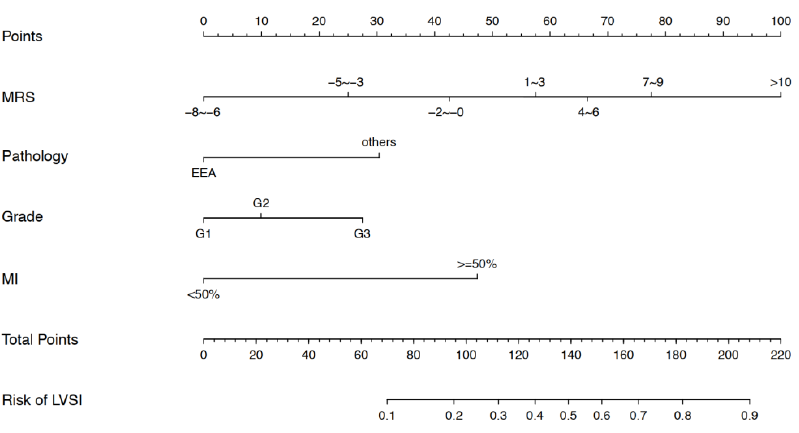
Figure 1. Nomogram to predict LVSI for EC patients.